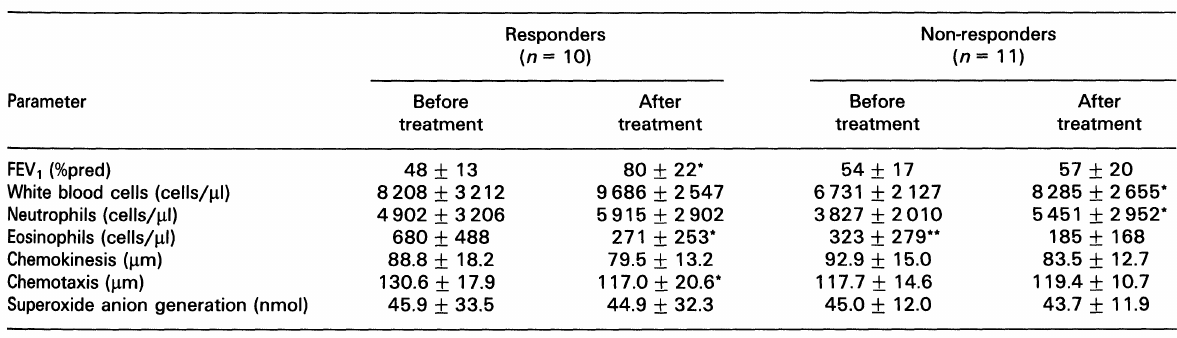
Table 3. Mean values (-t- SD) of haematology, migratory activity and superoxide anion generation from isolated peripheral neutrophils in asthmatic subjects who responded or not to systemic GCS treatment with an FEV1 increase of 20% or more Responders Non-responders (n-- 10) (n= 11) Parameter Before After Before After treatment treatment treatment treatment FEV1